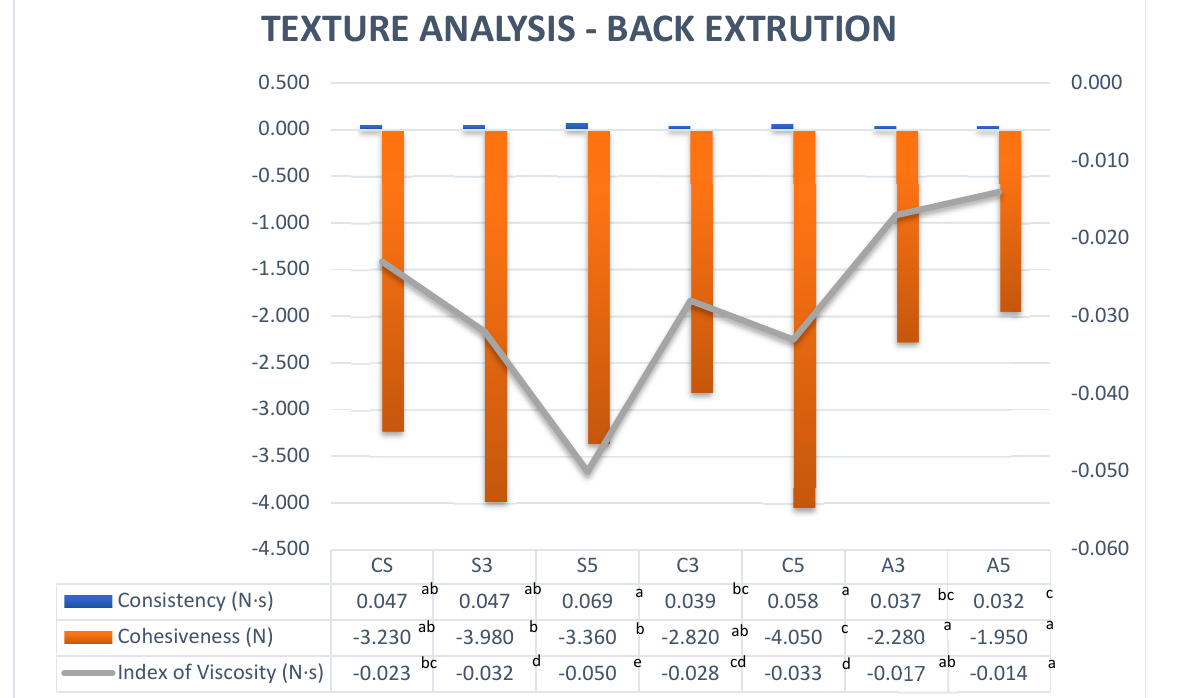
Figure 2. Back extrusion measurements for different proteins at different concentrations. Note: CS (Control Sample), S3 (3% Soy), S5 (5% Soy), C3 (3% Cricket), C5 (5% Cricket), A3 (3% Albumin), and A5 (5% Albumin). Different superscript letters in the same row indicate a significant difference ( p < 0.05).